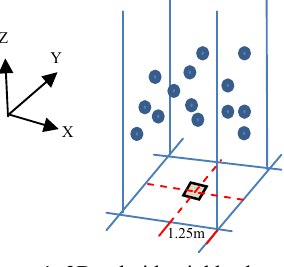
Figure 1: 3D cuboid